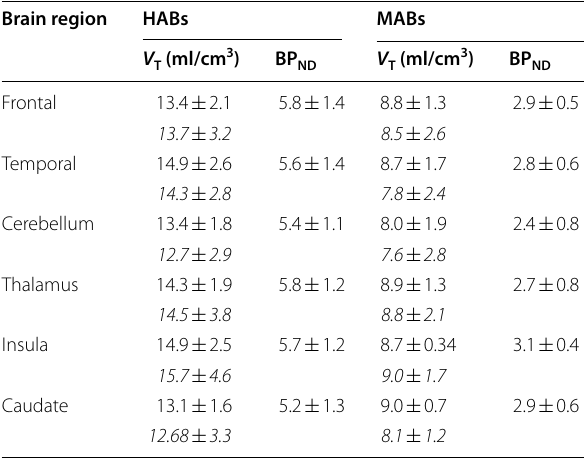
V T determined by SIME (top) and the 2TCM (bottom, italic), while BP ND was only derived from SIME